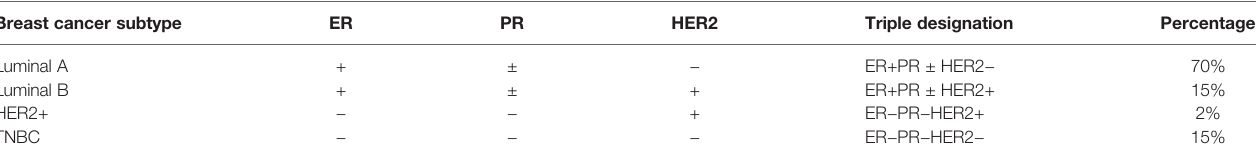
TABLE 1 | A standard immunohistochemistry (IHC) panel for the three main clinical biomarkers ER, PR, and HER2 can approximate the four intrinsic breast cancer molecular subtypes. Breast cancer subtype